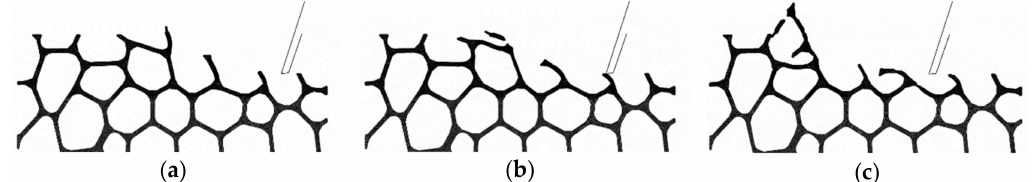
Figure 8. Workpiece-tool interaction (chip formation) during up milling (Model A, v c = 100 m / min, f z = 0.30 mm): 1st sweep ( a ); 3rd sweep ( b ); and 5th sweep ( c ).